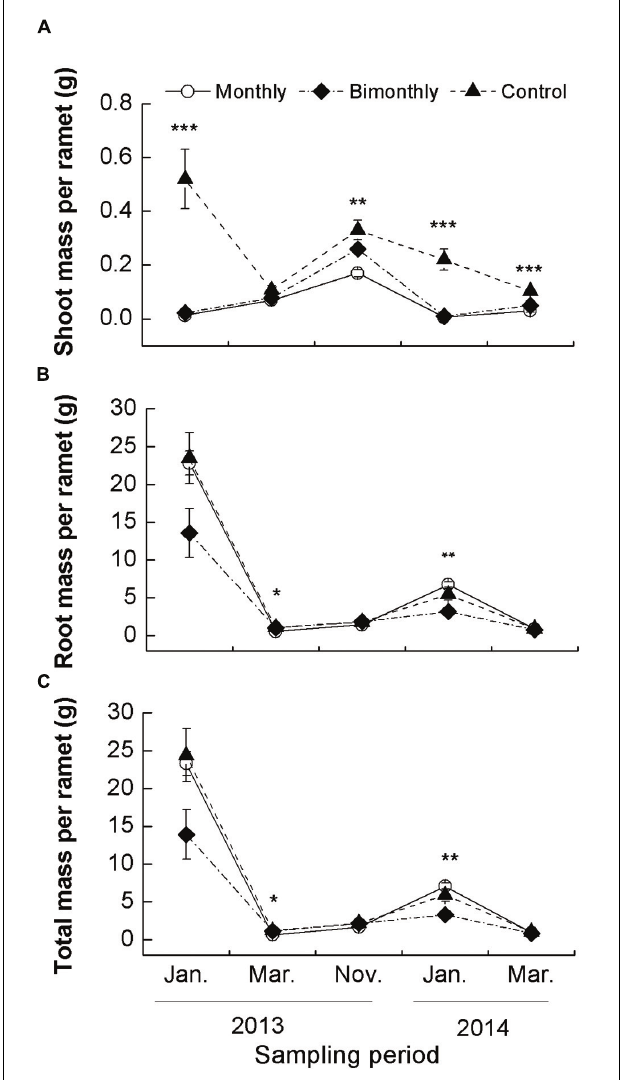
FIGURE 2 | Shoot (A), root (B), and total (C) mass per ramet of C. brevicuspis populations for three defoliation frequencies, January 2013–March 2014. The data are expressed as the mean ± standard error (SE). ∗ p < 0.05, ∗∗ p < 0.01, ∗∗∗ p < 0.001.